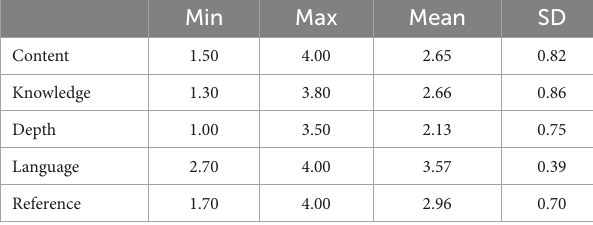
TABLE 1 Critical thinking pre-test mean and SD.